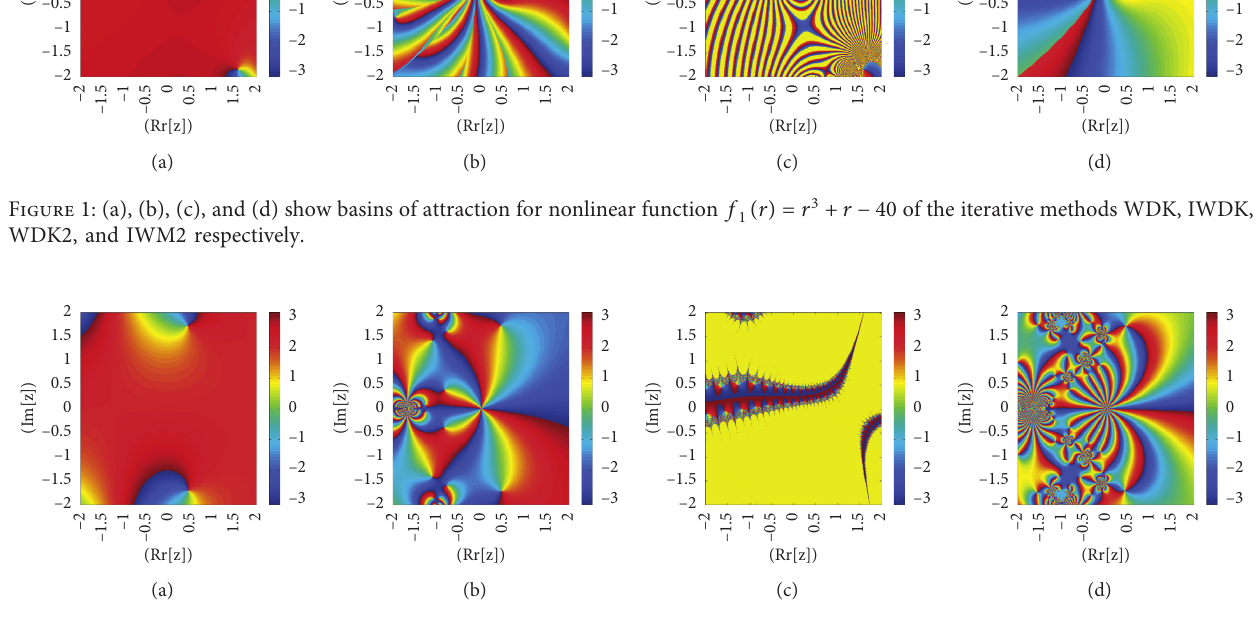
Figure 2: (a), (b), (c), and (d) show basins of attraction for nonlinear function f methods WDK, IWDK, WDK2, and IWM2, respectively.